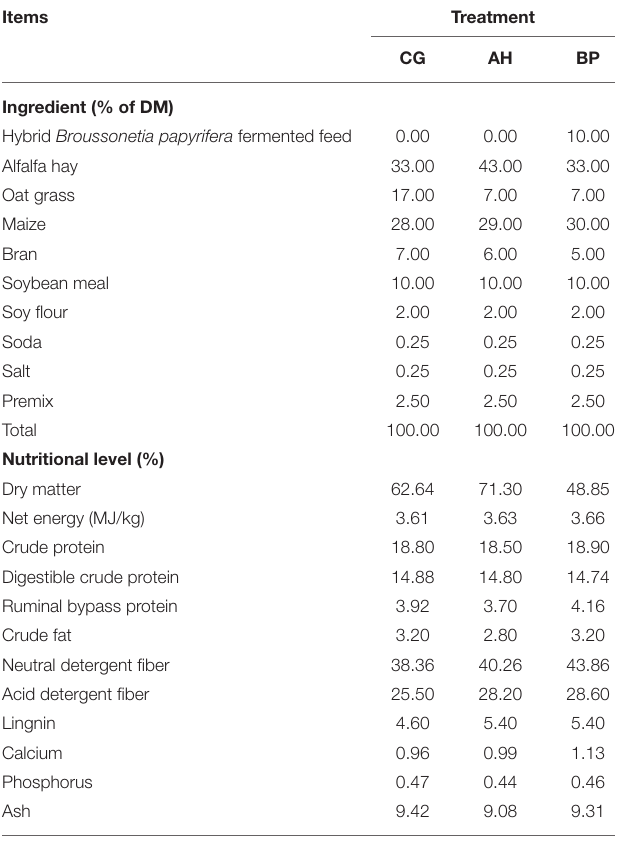
TABLE 1 | Ingredients and nutrient level of the three experimental diets based on oat Grass, alfalfa hay, and hybrid Broussonetia papyrifera .